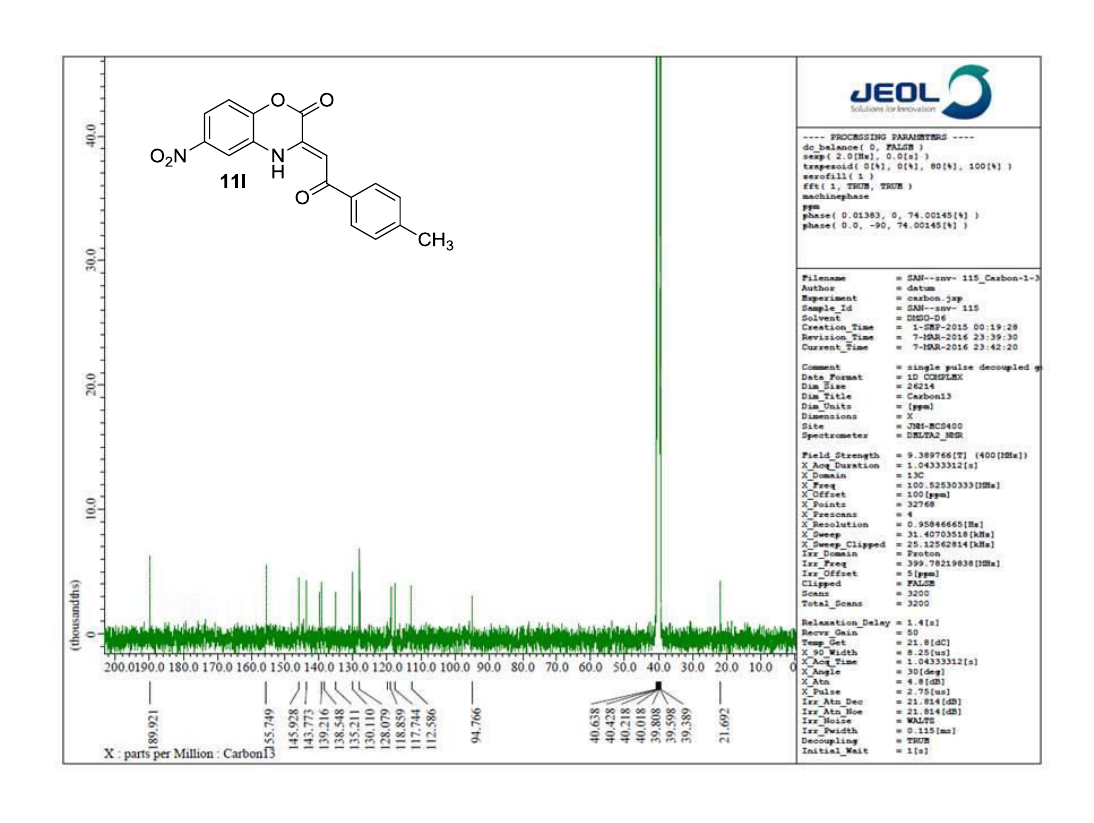
Figure 24. 13 C NMR Spectra of Compound 11l